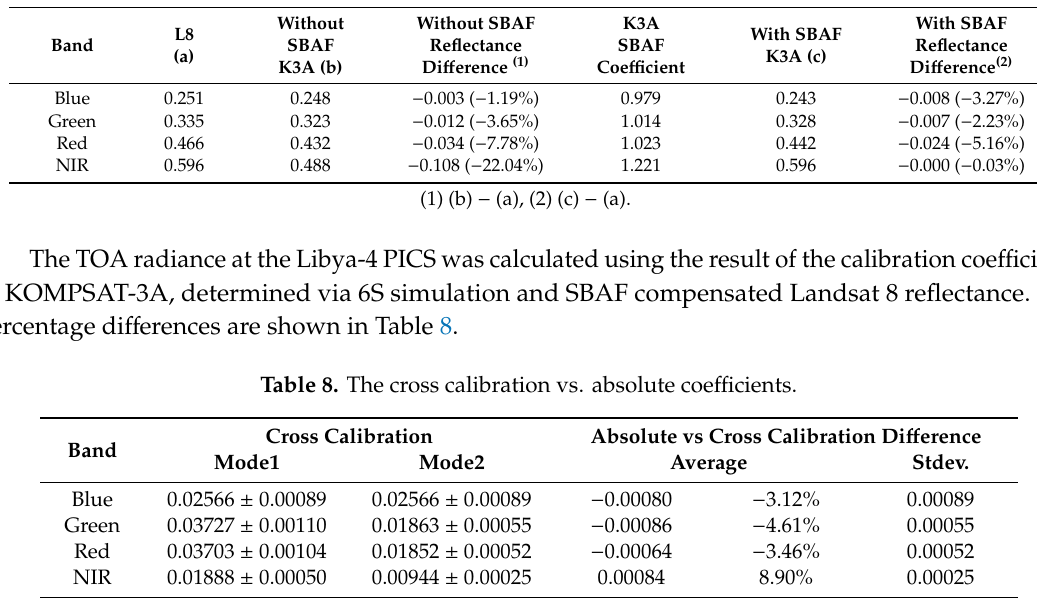
Table 7. Comparison of TOA reflectance for each band of Landsat-8 (L8) and KOMPSAT-3A (K3A) by spectral band adjustment factor (SBAF) (unit: %).